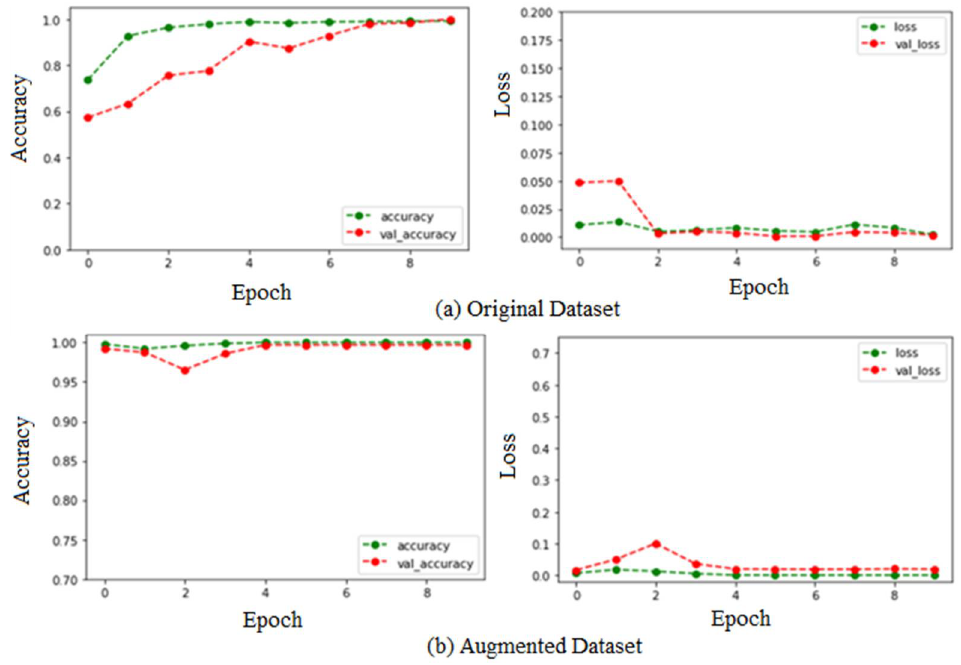
Figure 8. Loss and accuracy graph of AlexNet model for ( a ) original dataset and ( b ) augmented dataset.